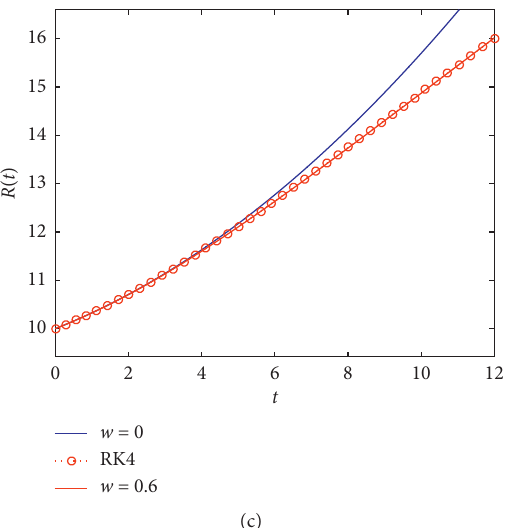
Figure 2: Comparison of three-term approximation SOR-like new iterative method, NIM, and RK4 for S ( t ), I ( t ), and R ( t ) versus time and ω .